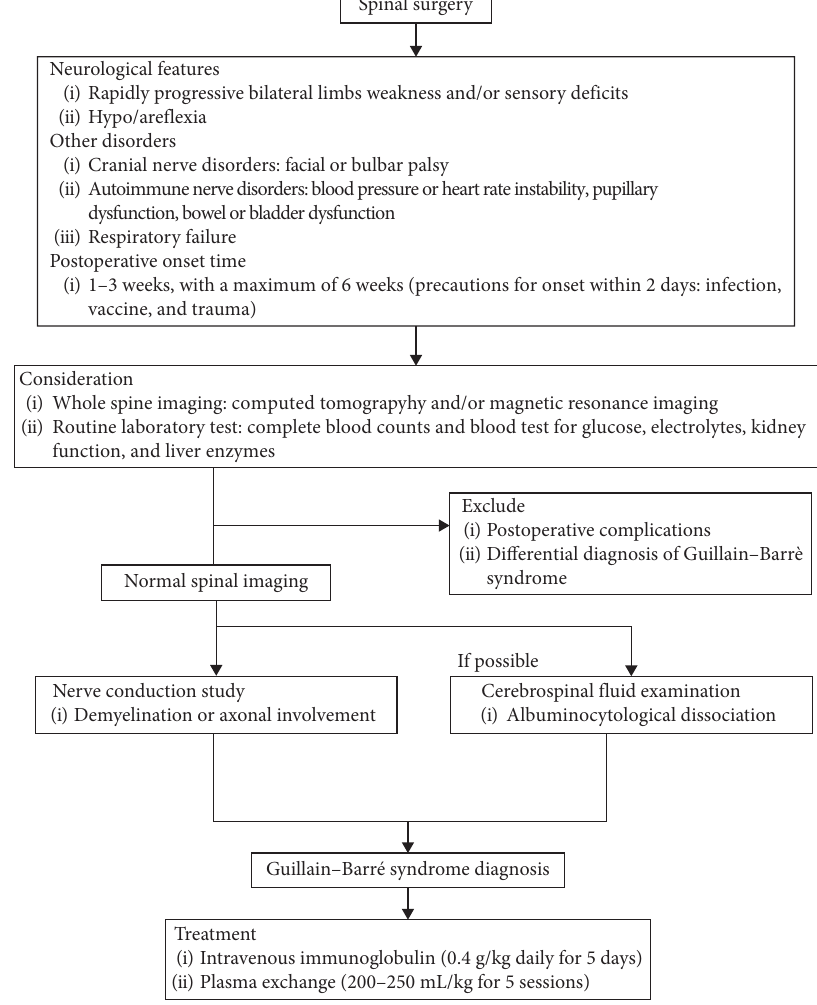
Figure 3: Strategies for diagnosis and treatment of Guillain–Barr´e syndrome after spinal